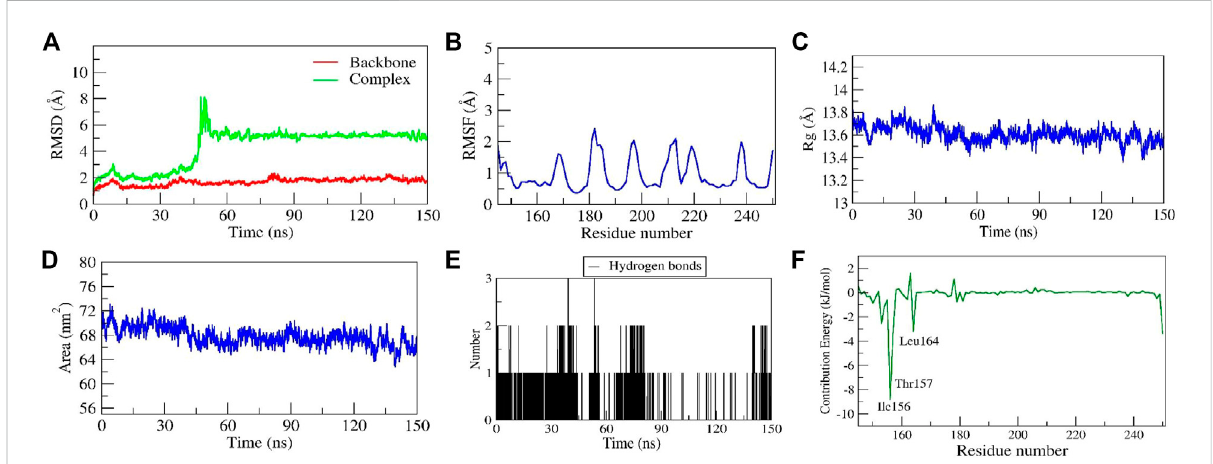
FIGURE 10 ParametersrepresentingthestructuralstabilityoftheDiosgenin-SRCcomplex. (A) BackboneandcomplexRMSD, (B) RMSF, (C) Rg, (D) SASA, (E) number of H-bond interactions, and (F) contribution energy plot demonstrates the signi fi cance of the ligand binding domain residues in stable complex formation.